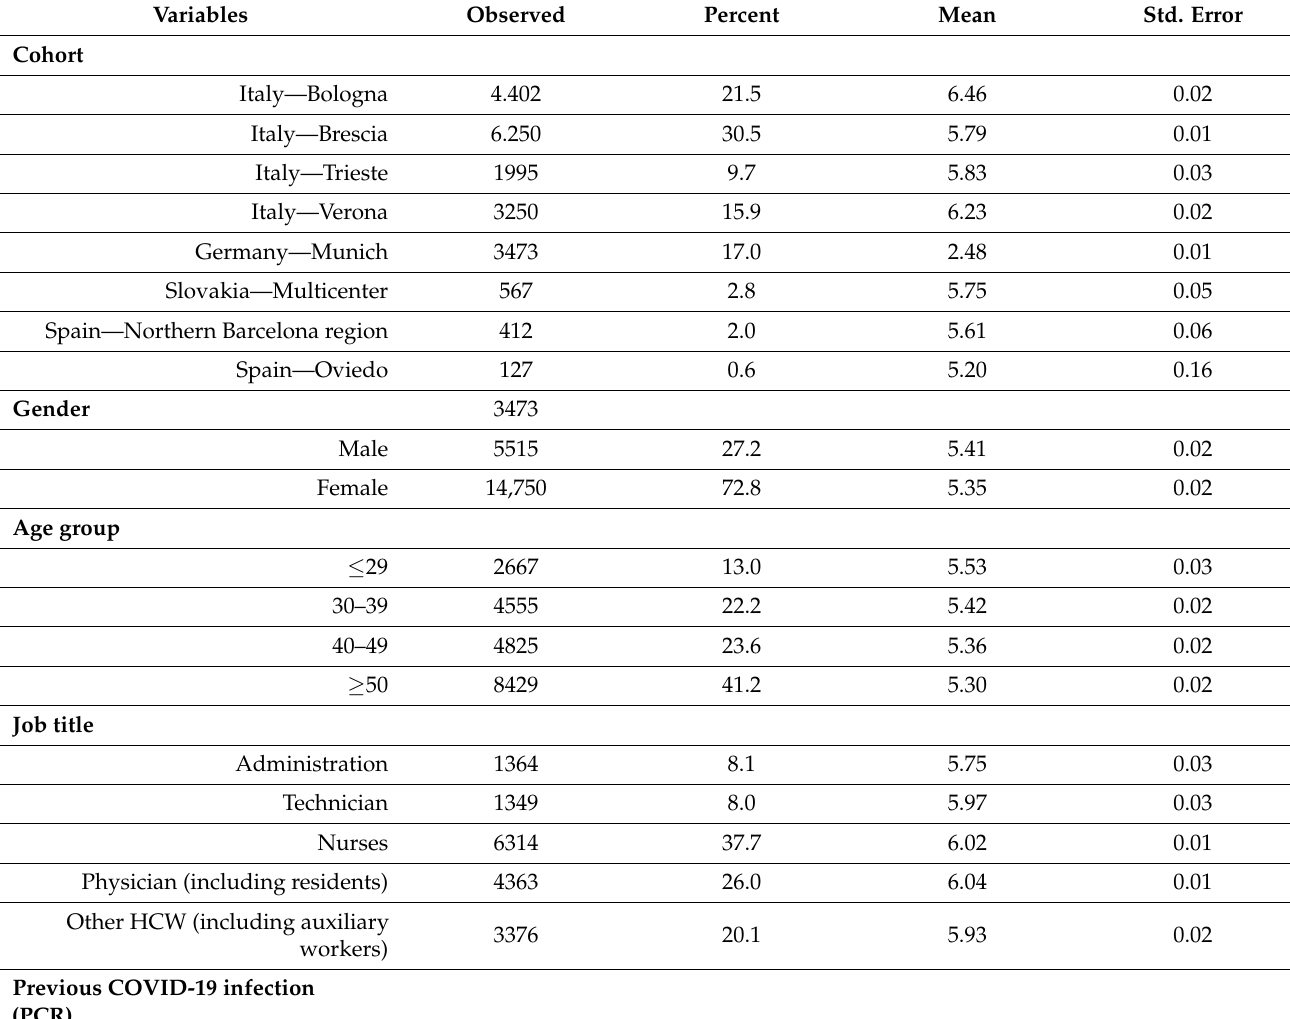
Table 1. Distribution of standardized serology test results by selected characteristics. Variables